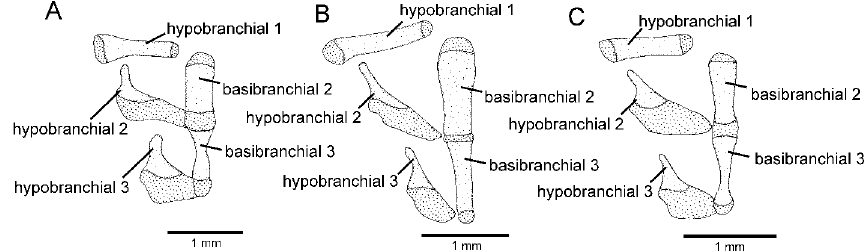
Figure 3. Partial ventral branchial skeleton, mid-left portion, dorsal view: ( A ) Trichomycterus auroguttatus ; ( B ) Trichomycterus jacupiranga ; ( C ) Trichomycterus saquarema Costa, Katz, Vilardo and Amorim, sp. nov. Larger stippling represents cartilages.